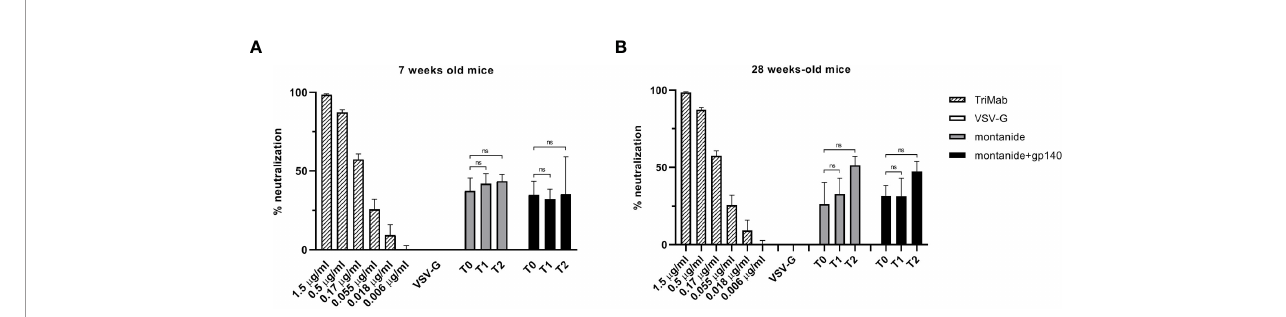
FIGURE 5 | HIV-QH0692 pseudoviruses-blocking activity of 7 (A) and 28 weeks-old C57BL/6 mice (B) before immunization (T0), 7 days (T1) and 14 days (T2) after immunization with montanide alone or in combination with gp140. NS, not signi fi cant.